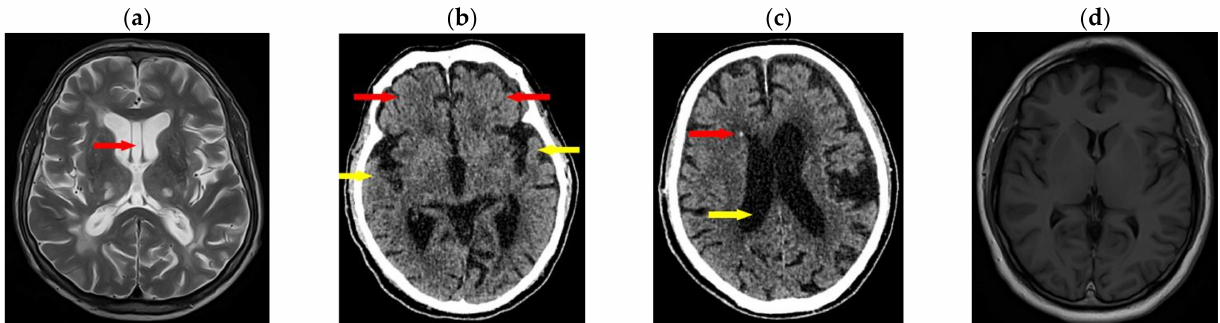
Figure 1. Typical findings in chronic traumatic encephalopathy: ( a ) A 58-year-old male with a history of repetitive trauma MRI in T2 sequence; cave of septum pellucidum (red arrow) is visible between enlarged lateral ventricles, ( b ) Advanced atrophy of frontal and temporal lobes (red and yellow arrows respectively) visible in plain CT scans, ( c ) Enlargement of ventricles in atrophied brain (yellow arrow); calcification (red arrow), suggestive of a neurodegenerative process, ( d ) MRI of a healthy person for